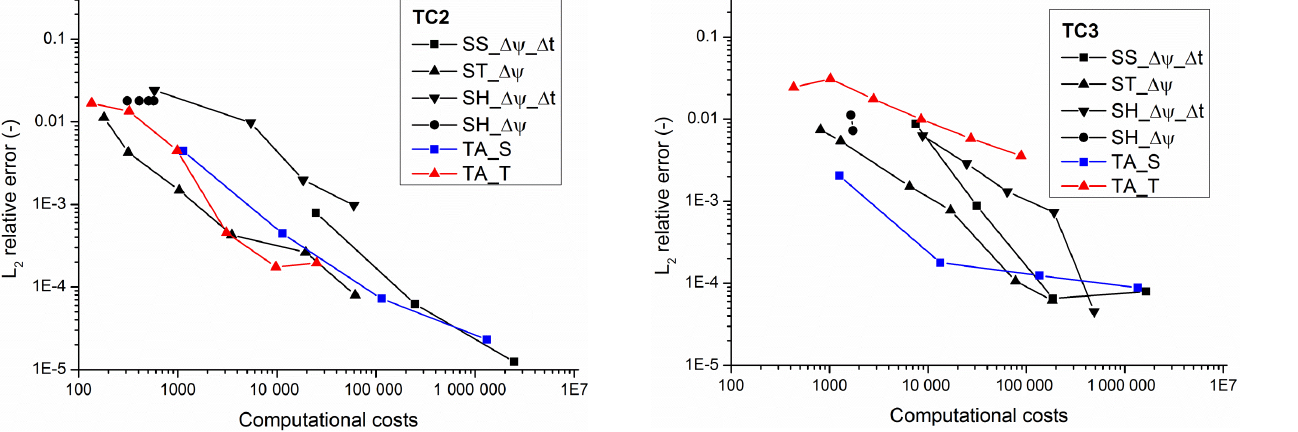
Figure 6. Evolution of the L 2 relative error with computational costs for TC2.